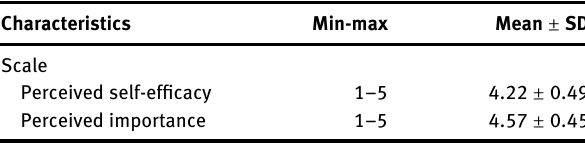
Table  : Distribution of the self-ef fi cacy for clinical evaluation scale scores of postgraduate midwifery students.